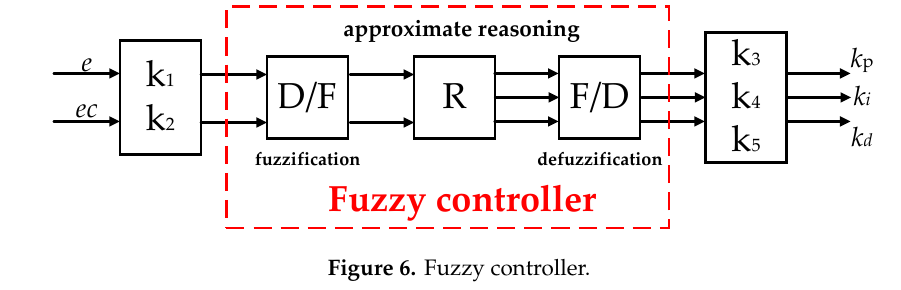
Figure 6. Fuzzy controller.